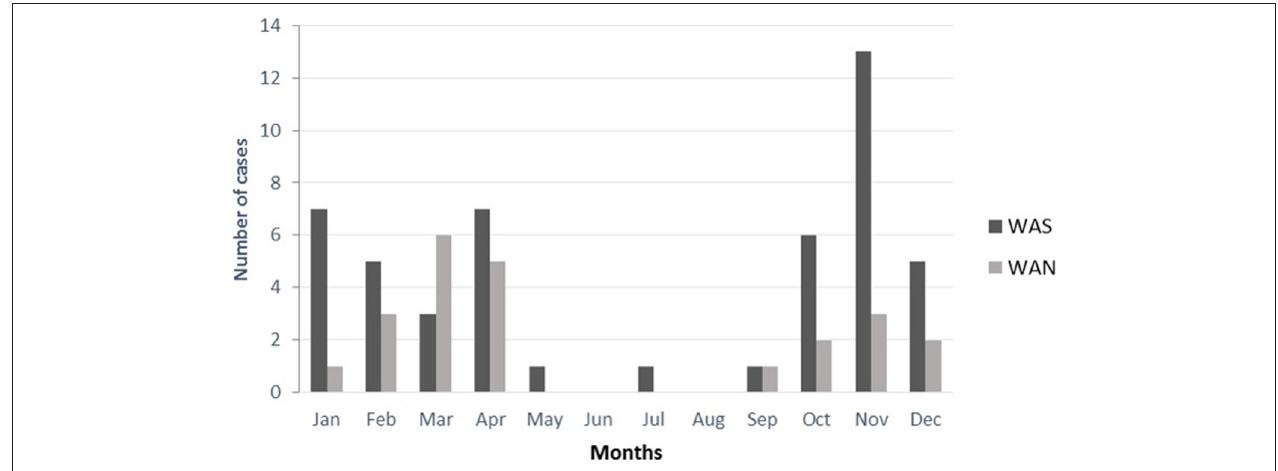
FIGURE 8 | Number of cases per month of potentially severe convection between 00 and 06 LT for the WAS and WAN subregions and for the period 1998–2012.